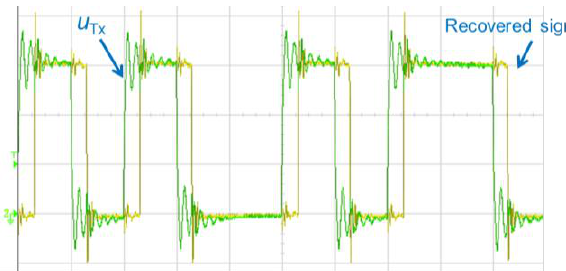
Figure 8. Sent ( u Tx ) and recovered ( u # ) communication signal (1V/div.; 250ns/div.)